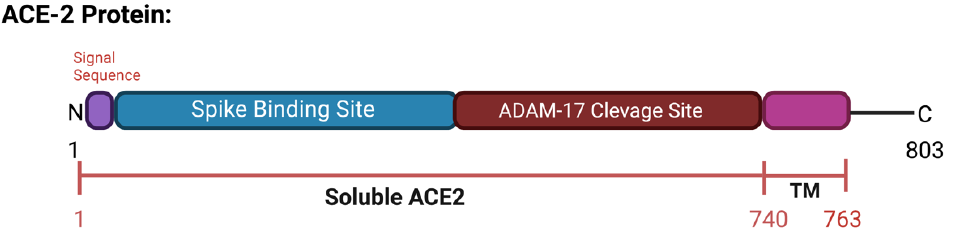
Figure 3. Schematic representation of the ACE2 protein. Includes spike binding site and ADAM-17 cleavage site and soluble ACE2. Created with BioRender.com.